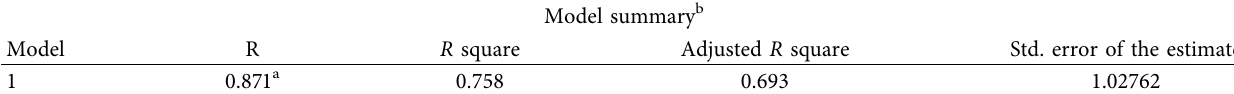
Table 2: Model summary results showing R square value.